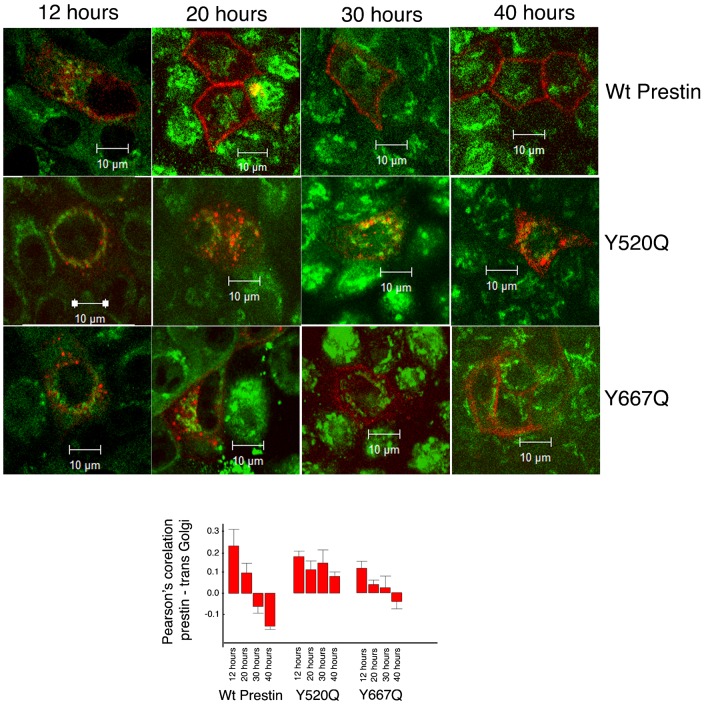
Egress from the Golgi is poor/absent in Y520Q and delayed in Y667Q.MDCK cells transiently transfected with prestin YFP, and the mutations Y520Q and Y667Q contained in the prestin YFP cassette were fixed after 12, 20, 30 and 40 hours after transfection. The cells were then stained with antibodies to the Golgi protein Giantin. While prestin YFP exits the Golgi at 20 hours, Y520 dos not egress from the Golgi and Y667Q leaves the Golgi after 40 hours. A graphical form of Pearson's correlation between prestin YFP and Giantin at the different time points is shown below. For wt prestin there was a significant difference on one way ANOVA between the Pearson's correlation between prestin and Giantin at all times compared to 12 hours: 12 hours vs 20 hours, P<0.05; 12 hours vs 30 hours, P<0.001; and 12 hours vs 40 hours P<0.001. In contrast, the differences in Pearson's correlation between Y520Q and Giantin at all times compared to 12 hours were not significantly different (P>0.05 on one way ANOVA). For Y667Q the Pearson's correlation with Giantin was significantly different on one way ANOVA between 12 hours and 40 hours (P<0.05), while the remaining two time points were not significantly different (12 hours vs 20 hours, P>0.05; 12 hours vs 30 hours, P>0.05). The mean values for the different time points were as follows: wt prestin 12, 20, 30 and 40 hours: 0.23 (+/−0.08 SE, n = 5), 0.09 (+/−0.04 SE, n = 10), −0.06 (+/−0.03 SE, n = 12), −0.162 (+/−0.02 SE, n = 13); Y520Q 12, 20, 30 and 40 hours: 0.17 (+/−0.02 SE, n = 5), 0.114 (+/−0.04 SE, n = 6), 0.145 (+/−0.06 SE, n = 13), 0.08 (+/−0.02 SE, n = 8); Y667Q 12, 20, 30 and 40 hours: 0.112 (0.03 SE, n = 13), 0.04 (+/−0.02 SE, n = 9); 0.026 (+/−0.05 SE, n = 8) and −0.04(+/−0.03 SE, n = 8). The scale bar is 10 microns.